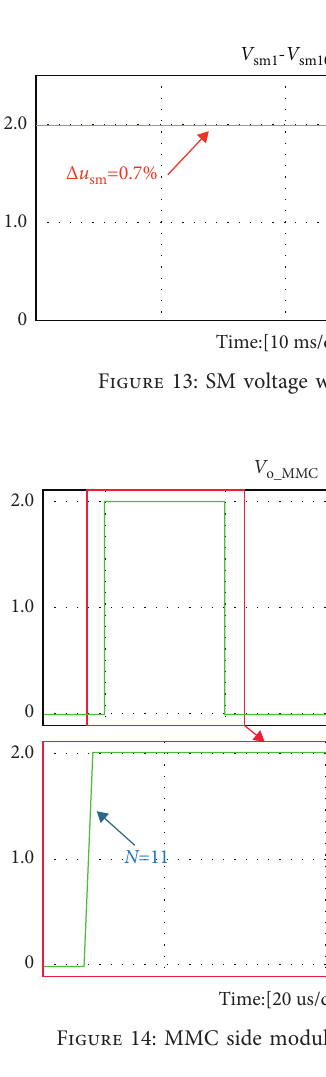
Figure 12: Simulation control strategy of QP-M 2 DC system.